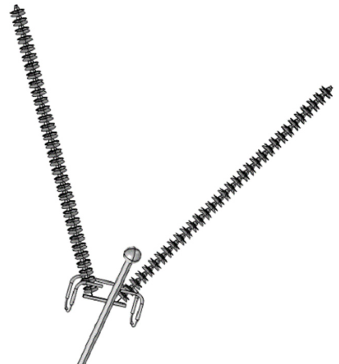
Figure 1. The corona discharge condition of V-shaped suspension insulator string grading ring of No.1 bus of a 500 kV substation. The type of the grading ring of the V-shaped suspension insulator string of No. I bus is JPL-1200 × 860, and pipe diameter is 50 mm. The V-shaped insulator string consists of 33 pieces of XWP2-100 insulators and the length of the insulator string and connecting fittings is 5.4 m. The 3-D simulation calculation model of the electrostatic field in the grad- ing ring area of a V-shaped suspension insulator string established in COMSOL finite el- ement simulation software is shown in Figure 2.